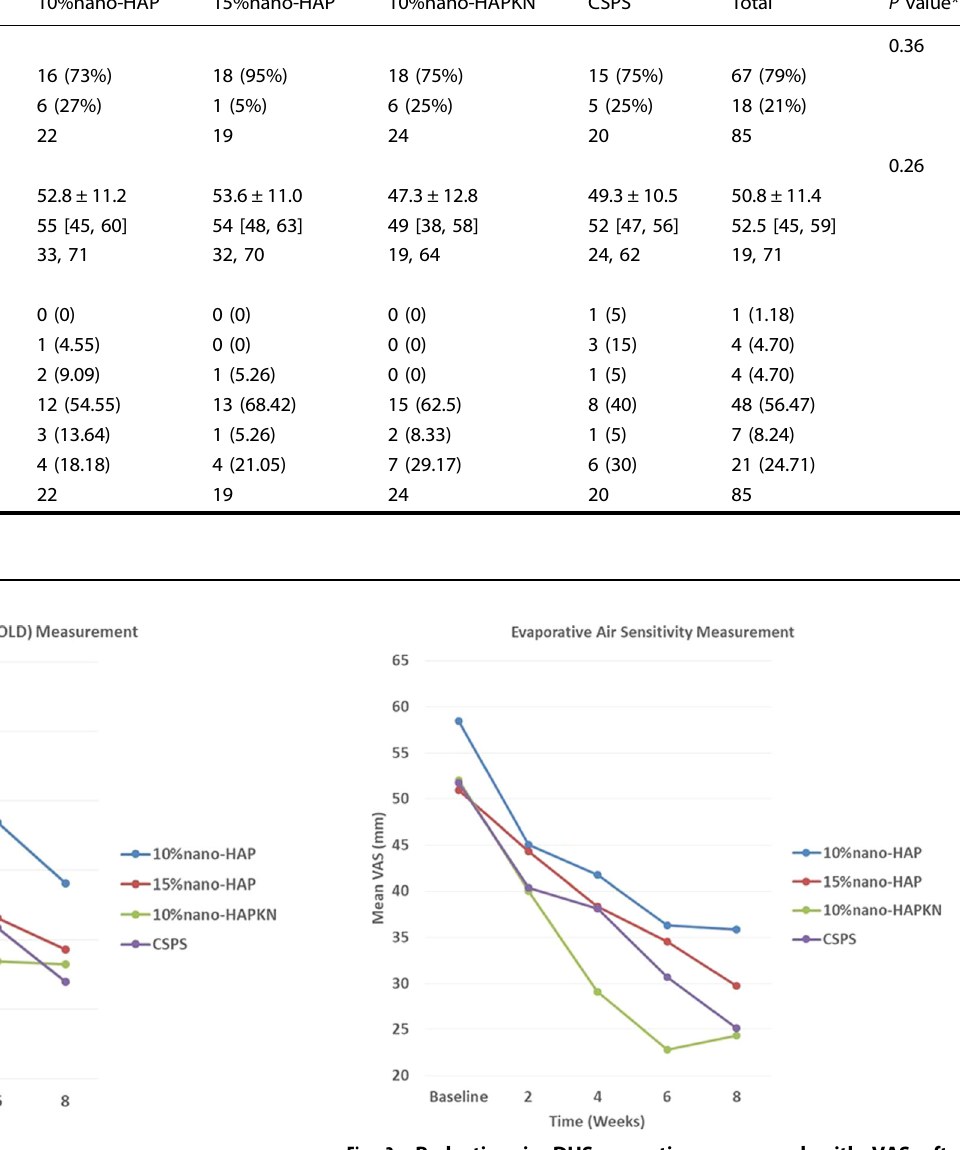
Fig. 2 Reduction in DHS over time measured with VAS after a cold stimulus. For each product, there was a signi fi cant ( P < 0.001) reduction in DHS at each time point. Comparing the reduction of DHS among the products, the following product pairs differed signi fi cantly ( P < 0.001) from each other at the indicated measure- ment time period. Week 2: 10%nano-HAPKN and 10%nano-HAP; week 4: 10%nano-HAPKN and 10%nano-HAP; week 6: 10%nano- HAPKN and 10%nano-HAP, 15%nano-HAP and 10%nano-HAP, CSPS and 10%nano-HAP; and week 8: CSPS and 10%nano-HAP. CSPS calcium sodium phosphosilicate.